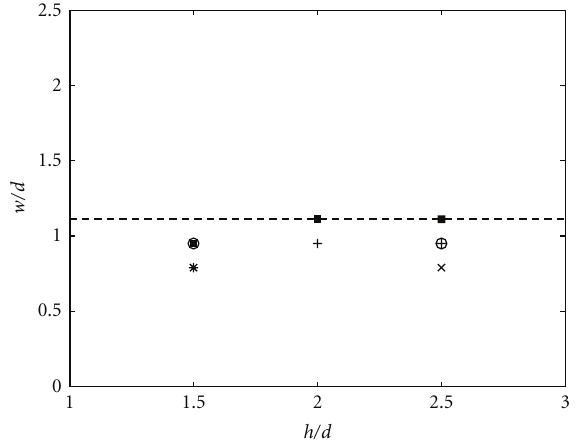
Figure 9: Experimental results for pile groups and proposed expression (7): w/d = 1 . 11 (dashed line). Γ = 3 no fail (black squares); Γ = 3 fail (+); Γ = 2 no fail (circles); Γ = 2 fail